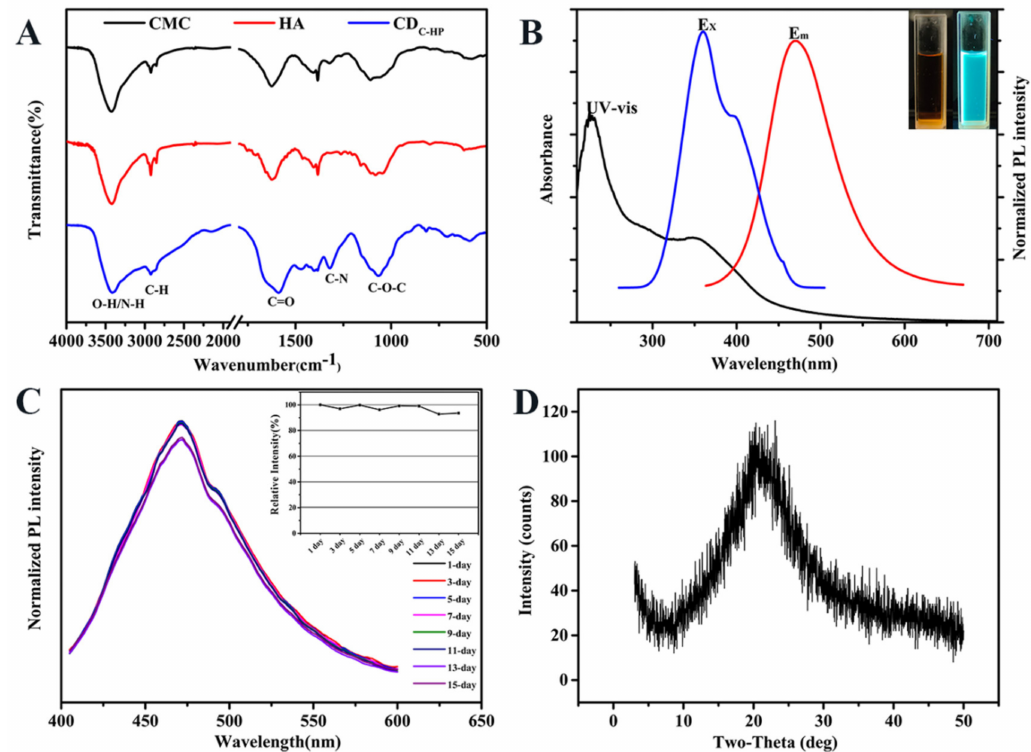
Figure 1. FT-IR spectrum of CMC, HA, and CD C-HP ( A ); UV-vis absorption, excitation and emission spectra of CD C-HP ( B ); The inset in Panel B: optical images obtained under daylight ( left ) and a UV beam of 365 nm ( right ); The photo stability of CD C-HP at different time ( C ); XRD pattern of CD C-HP ( D